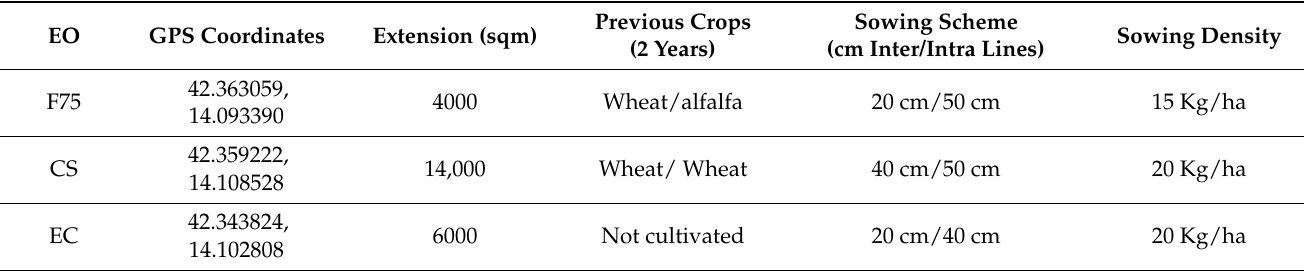
Table 7. Characteristics of the experimental